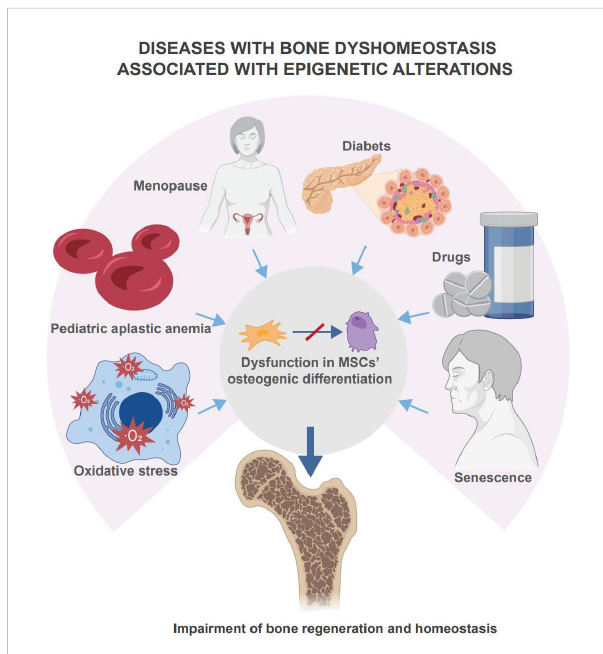
FIGURE 1 Disease with bone dyshomeostasis associated with epigenetic alterations. Multiple diseases, drugs, or body senescence will lead the skeletal system to bone dyshomeostasis. Among these situations, changes in epigenetic regulation affect the osteogenic differentiation of MSCs and mediate the loss of bone homeostasis and impairment of bone